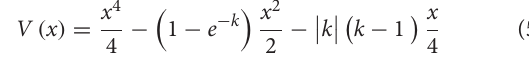
this deeper attractor, it will take stronger gusts of wind to push the ball out of it. Thus, this attractor is more stable than the